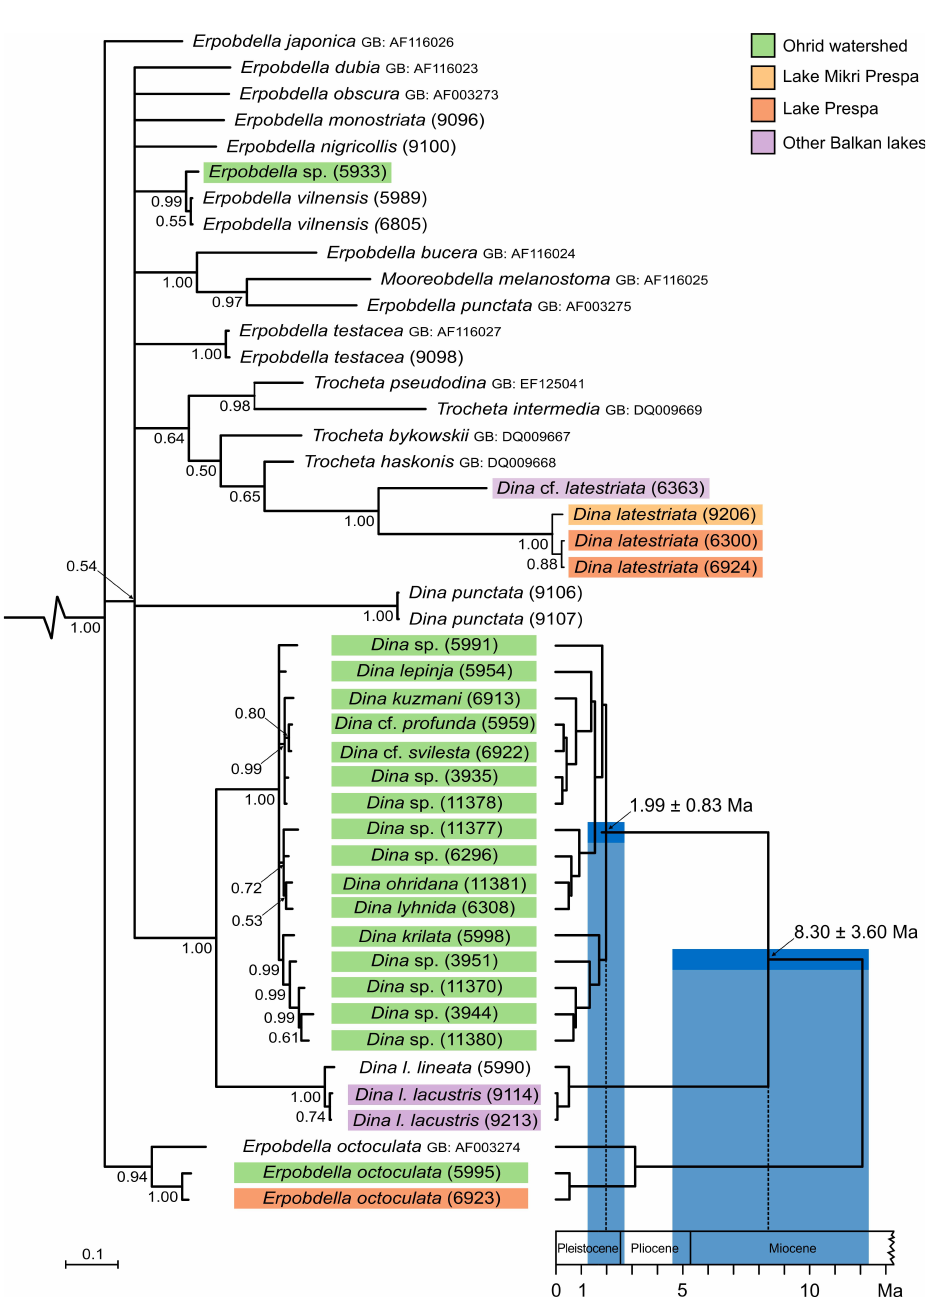
Fig. 3. Bayesian phylogeny of selected species of Erpobdellidae inferred from the mitochondrial COI gene (left). The outgroup taxa Glossiphonia complanata and Batracobdella algira were removed a posteriori . Bayesian posterior probabilities are given next to the nodes. The scale bar indicates the number of substitutions per site. A strict clock Bayesian tree of selected taxa from the Ohrid Dina flock is shown on the right. The 95% confidence intervals for the onset of diversification and for the split with taxa from outside the lake are indicated by blue bars. Specimens from the Balkans are marked by coloured bars. Number in parenthesis behind taxon names are the respective DNA voucher numbers (see Table 1 for details). Accession numbers are provided for sequences obtained from GenBank.